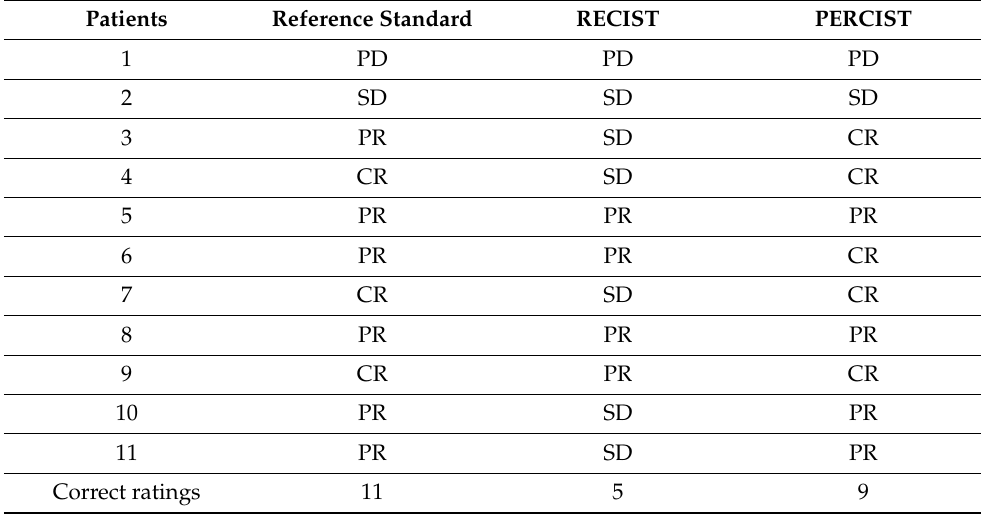
Table 3. Results of the ratings according to the RECIST 1.1- and PERCIST-criteria (CR: complete response, PR: partial response, SD: stable disease, PD: progressive disease).